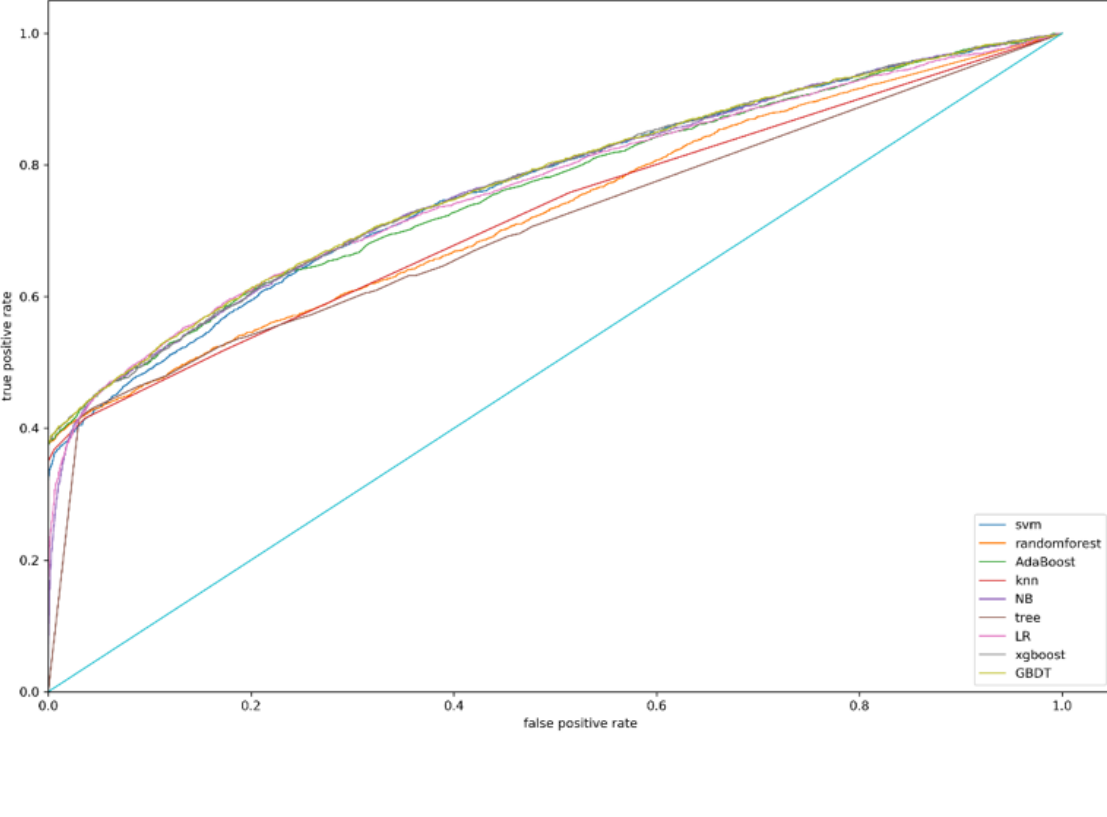
Figure 1. Overall area under the receiver operating characteristic curves for internal validation dataset. SVM: support vector machine; knn: